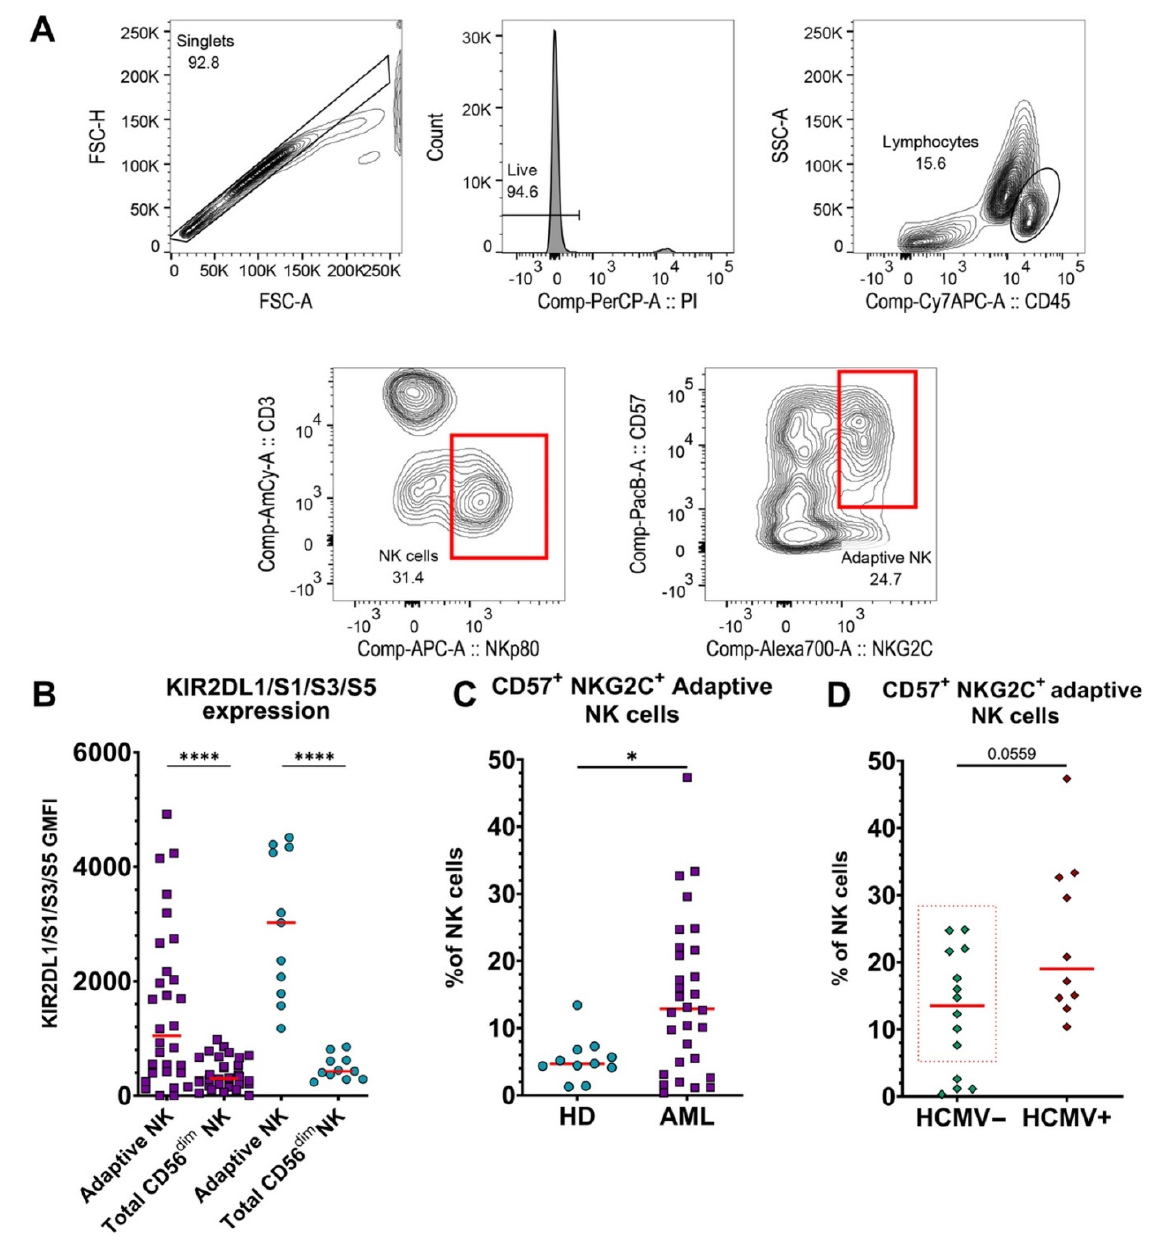
Figure 2. CD57 + NKG2C + adaptive NK cells are prevalent in the peripheral blood of AML patients. PBMCs from 30 untreated AML patients and HDs were assessed for adaptive NK cells. A reduced number of AML patients is due to low numbers of NK cells in two untreated blood samples. ( A ) Gating strategy for adaptive NK cells. First, single cells were selected in a forward scatter area (FSC-A) vs. forward scatter height (FSC-H) plot. Then, living cells were selected as propidium iodide (PI)-negative. Lymphocytes were identified as CD45 + SSC low cells in a CD45 vs. side scatter area (SSC-A) dot plot. NK cells were defined as CD3 - NKp80 + lymphocytes. Finally, CD57 + NKG2C + NK cells were identified as adaptive NK cells. ( B ) GMFI of KIR2DL1/S1/S3/S5 expression on adaptive NK cells vs. total mature CD56 dim NK cells from AML patients (purple squares) and HDs (blue circles). ( C ) Comparison of % CD57 + NKG2A + adaptive NK cells from peripheral blood of HDs and AML patients. ( D ) Percentage of CD57 + NKG2C + adaptive NK cells in blood of untreated AML patients ( n = 24) that tested negative for HCMV (HCMV − ) vs. positive (HCMV + ). The red dotted rectangle emphasizes HCMV – patients with significant percentages of adaptive NK cells. For panels ( B – D ), red lines represent medians. Mann–Whitney nonparametric U test was used for statistical analysis. ns— p > 0.05; *— p < 0.05; ****— p < 0.0001. A p -value is specified in cases when it is close to 0.05.